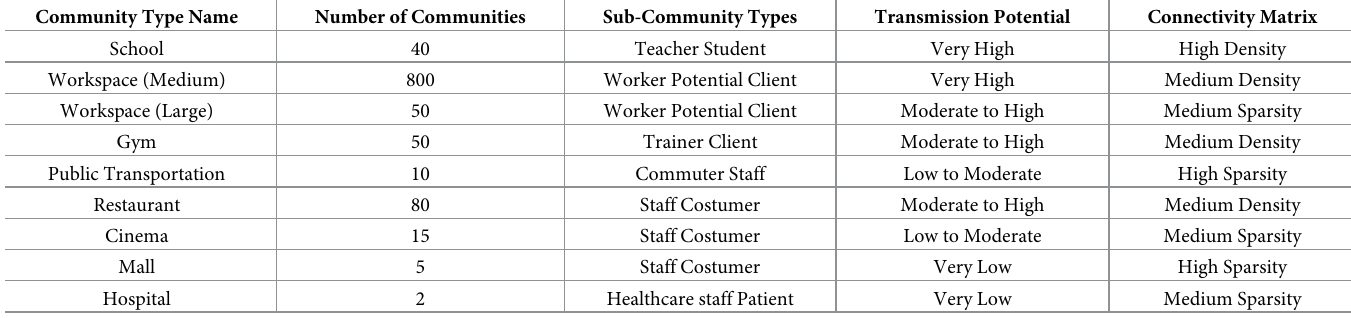
Table 6. The design of the communities and subcommunities for an exemplary city